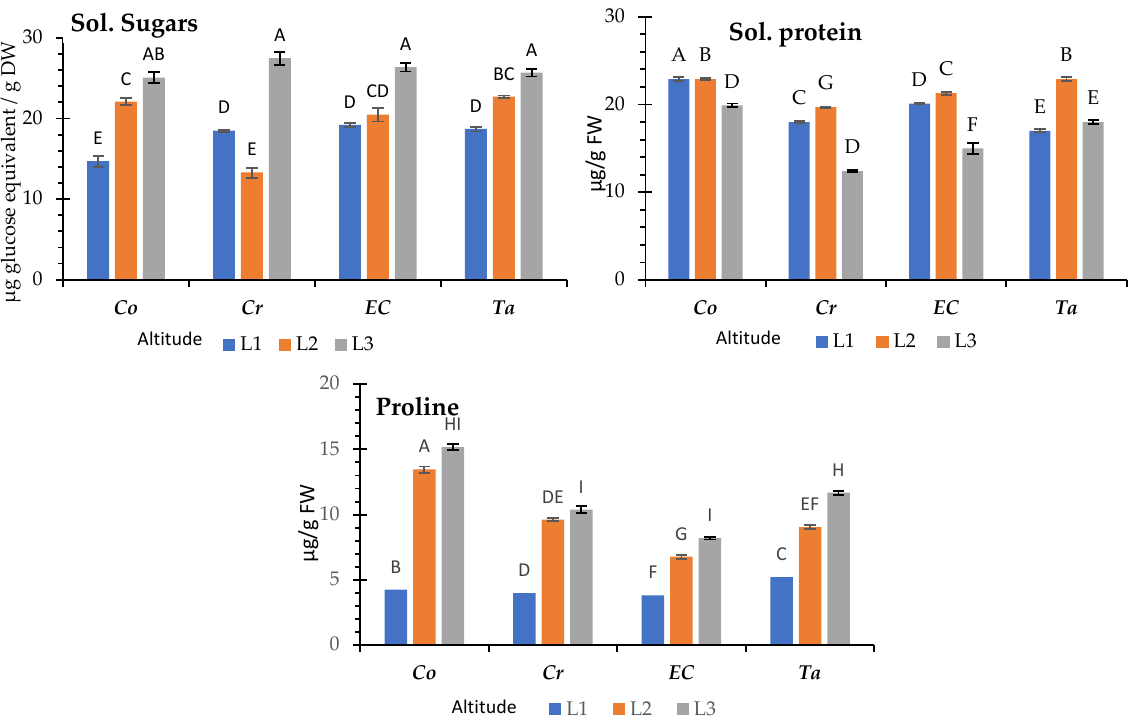
Figure 5. Total soluble sugar, total soluble proteins, and proline contents in the leaves of four plant species from different altitudes. Each value is the mean of three replicates ± SE. Bars with different letters are significantly different at p ≤ 0.05. Abbreviations: L1 = altitude 1; L2 = altitude 2; L3 = altitude 3; Co . = Cotineaster orbicularis ; Cr. = Crataegus sinaica; Ec. = Echinops spinossissmus; Ta. = Tanacetum sinaicum.